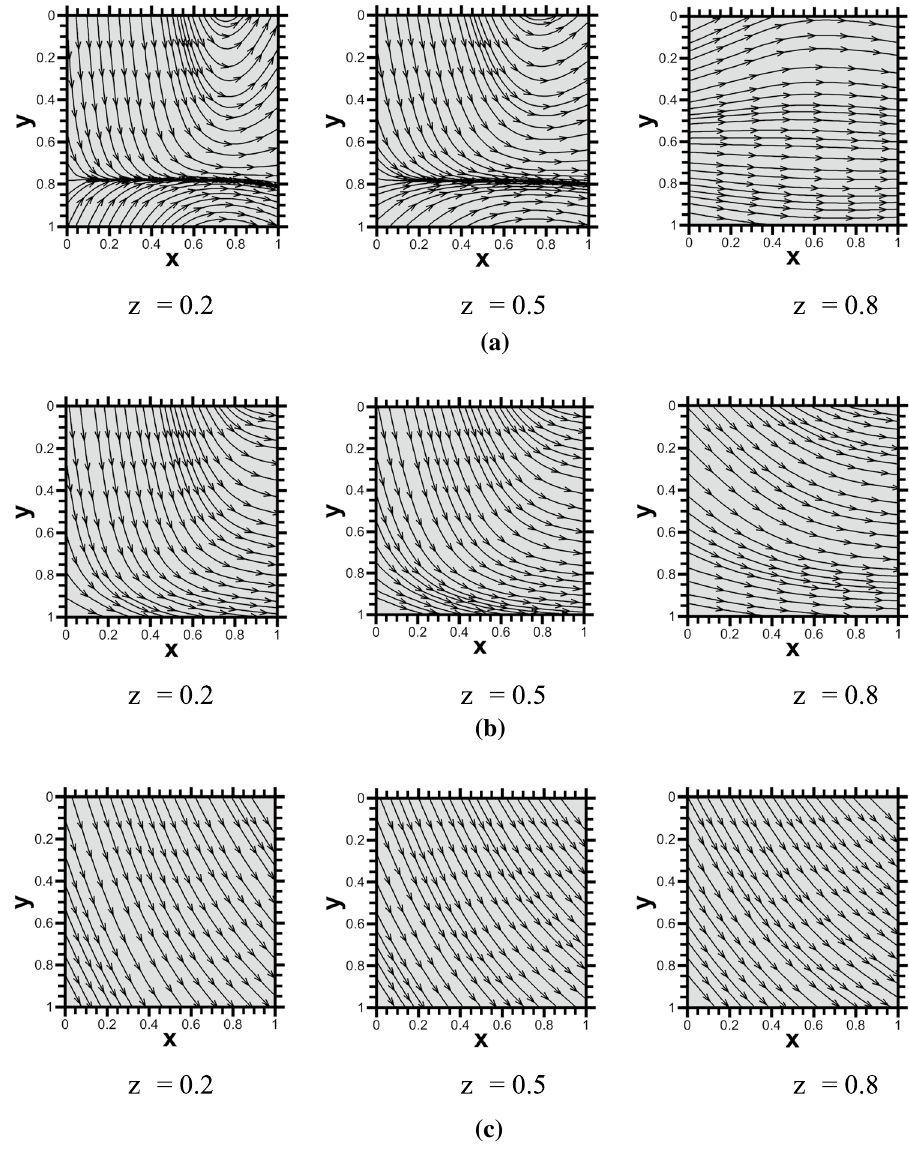
Fig. 15 A sample of the stream lines in the longitudinal section for passing plates through the 𝜐 width ( = 0.25) a t = 0.05, b t = 0.1, c t =